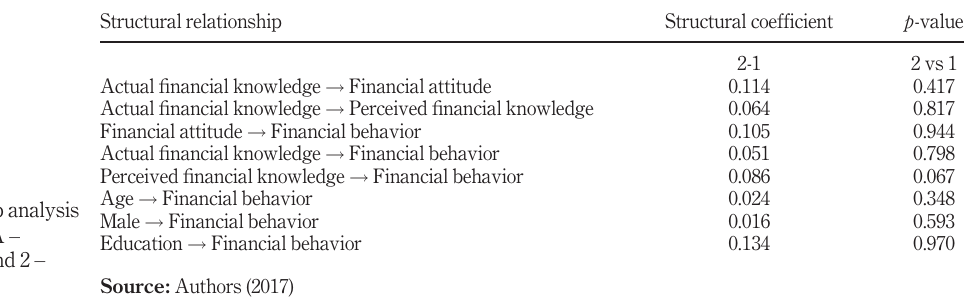
Table VII. Multi-group analysis